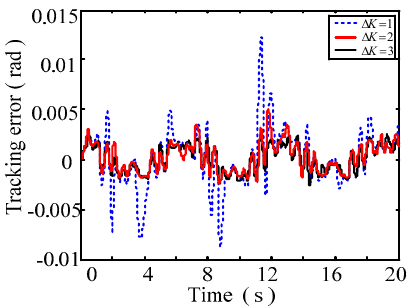
Figure 15. The curves of angle tracking error for different step sizes.